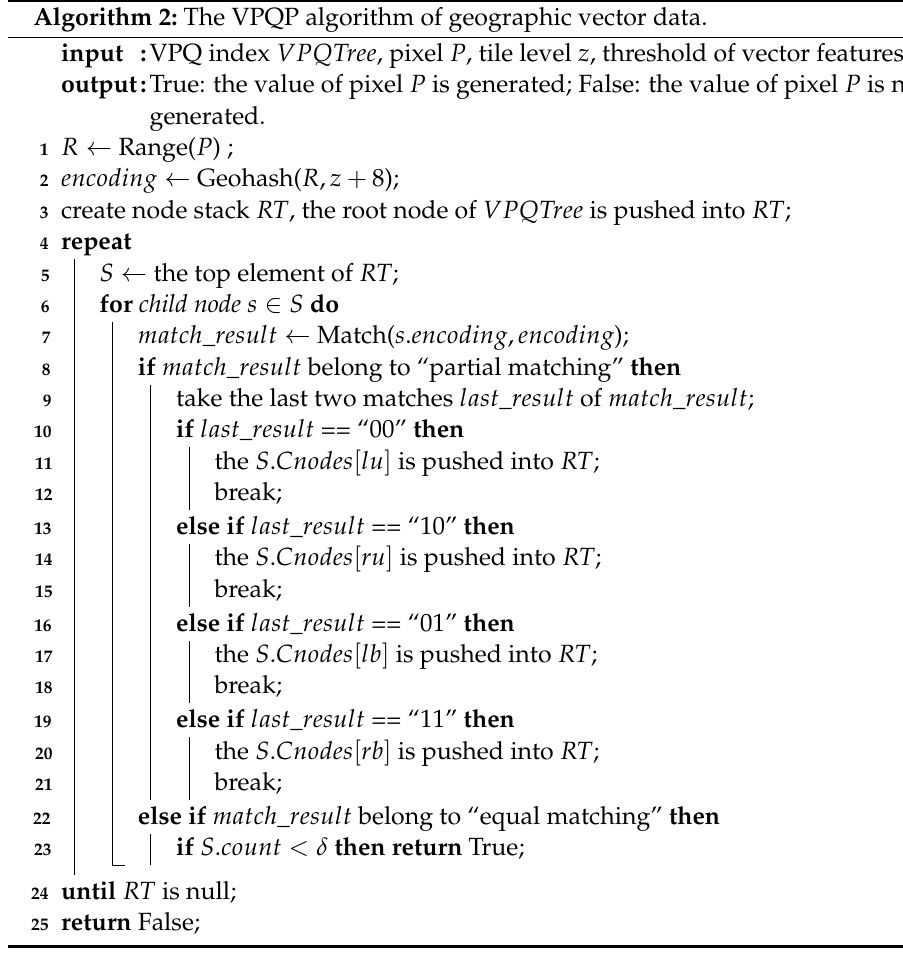
Algorithm 2: The VPQP algorithm of geographic vector data.